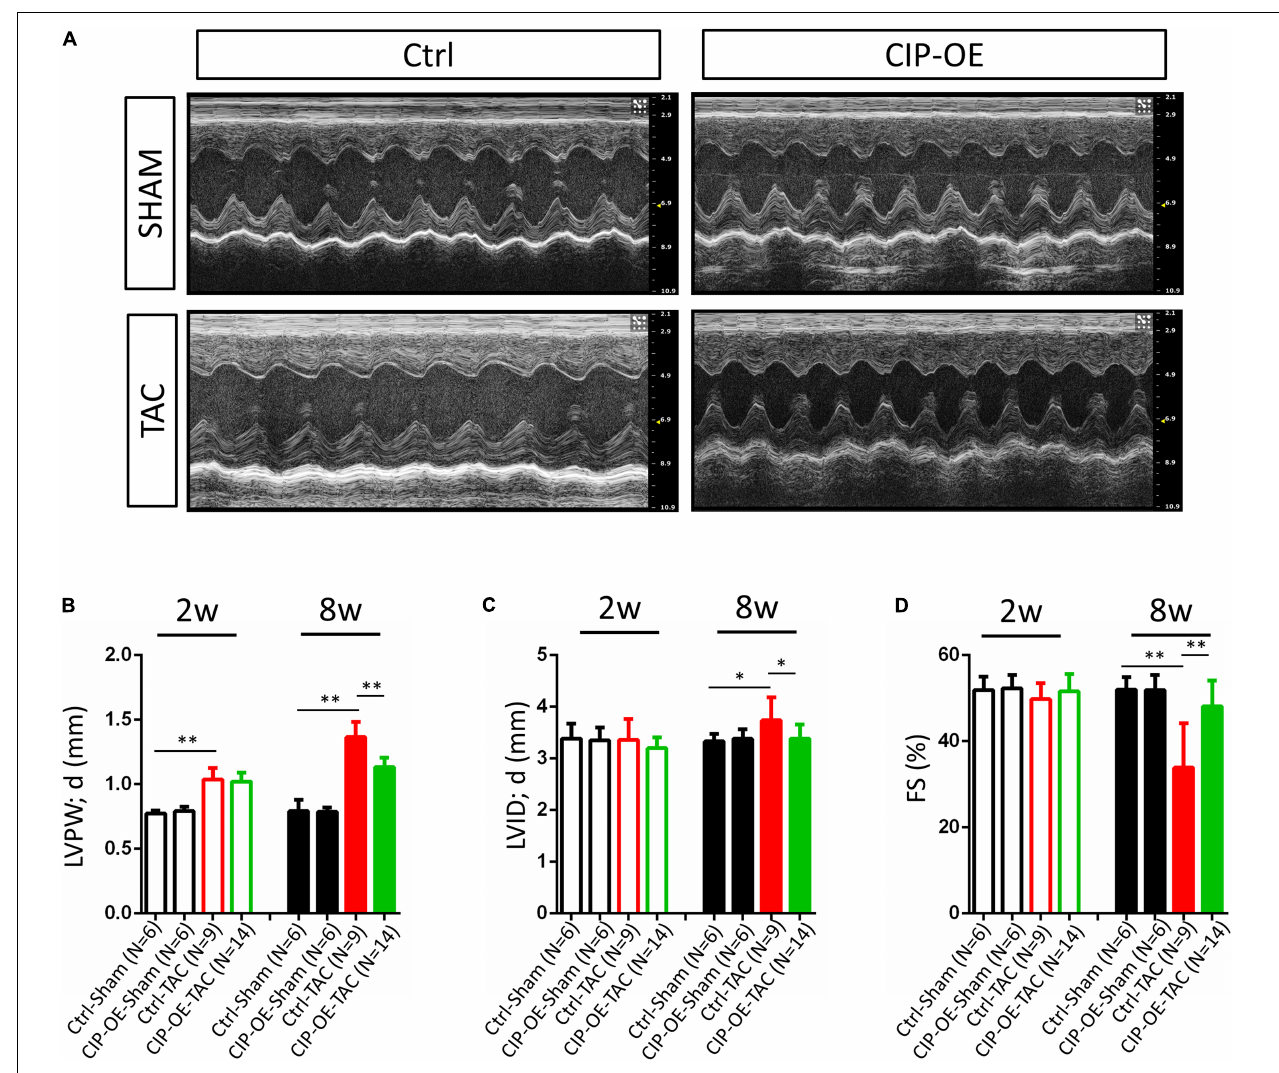
FIGURE 3 | Cardiac-overexpression of CIP preserves cardiac function during the disease progression toward heart failure. (A) Representative echocardiographic images from indicated group at 8 weeks after operation. (B) Left ventricular posterior wall thickness at end-diastole (LVPW;d), (C) Left ventricular internal dimension at end-diastole (LVID;d) and (D) Fractional shortening (FS) of CIP-OE mice and their control littermates with TAC or Sham operation determined by echocardiography at 2 weeks (2w) and 8 weeks (8w) after operation. N number for each group is show. The significance between groups was tested with 1-way ANOVA with post hoc Tukey’s test. ∗ P < 0.05; ∗∗ P <